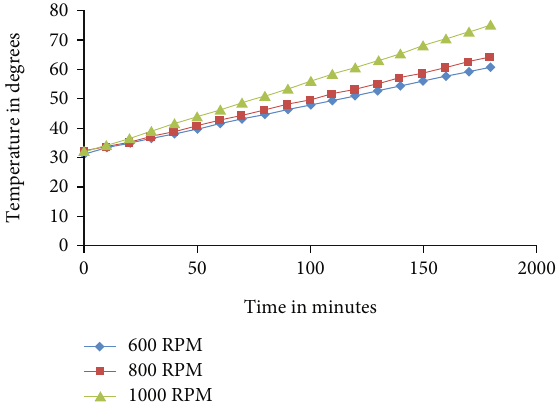
Figure 15: Time – temperature graph of nylon bearings.